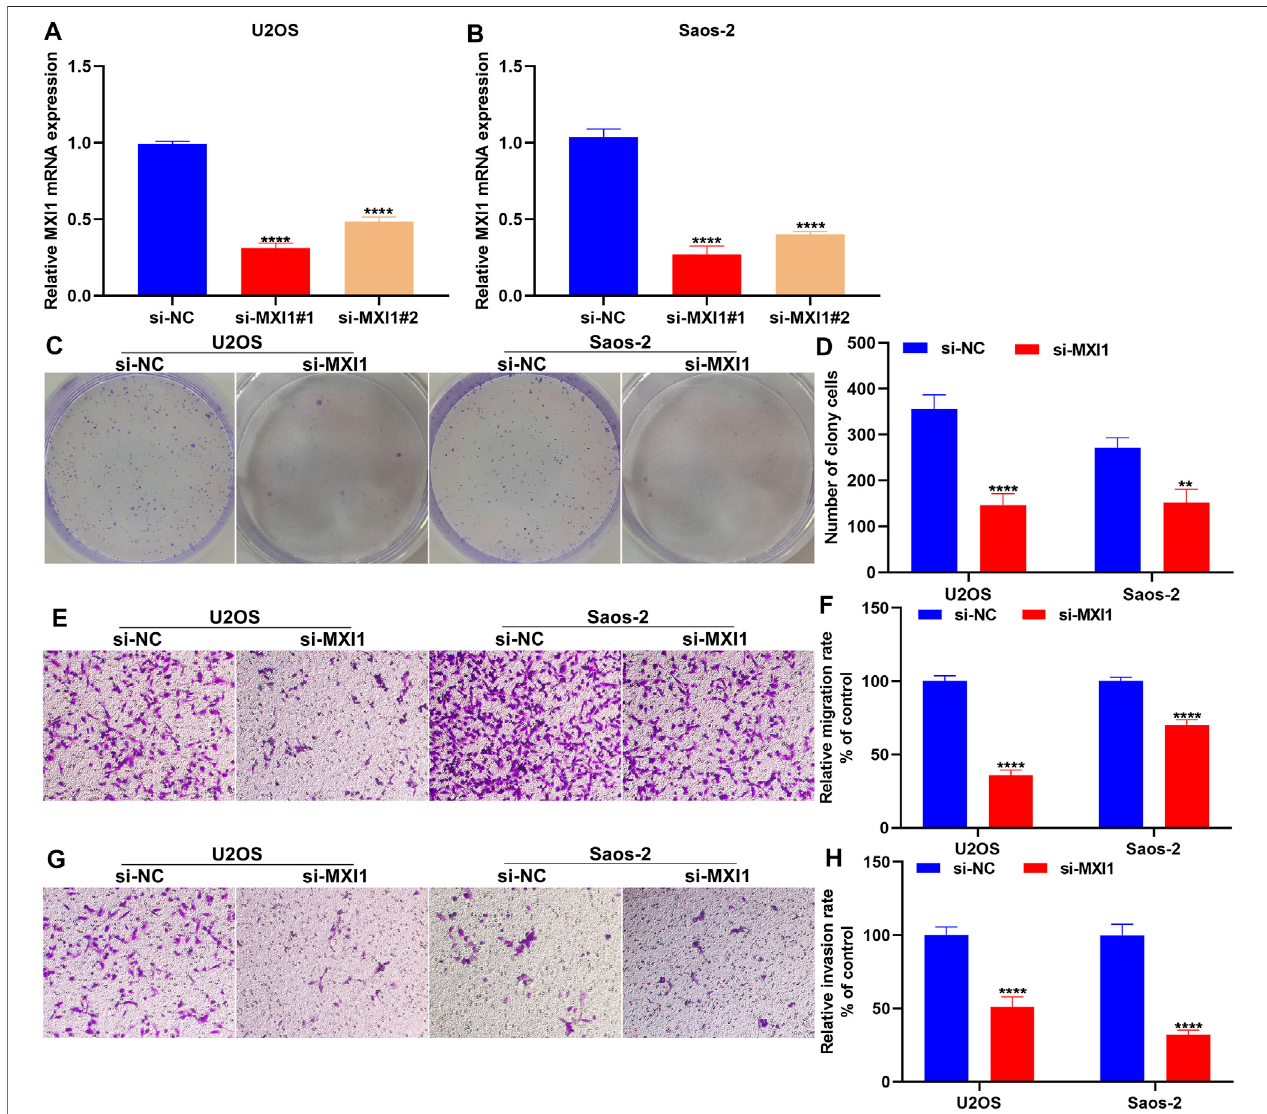
FIGURE 12 | Silencing MXI1 attenuates proliferation, migration, and invasion of osteosarcoma cells. (A, B) RT-qPCR for verifying the expression of MXI1 in U2OS and Saos-2 cells following transfection with its speci fi csiRNAs. (C, D) Colony formation formeasuringthe proliferative capacity ofU2OS and Saos-2 cells after